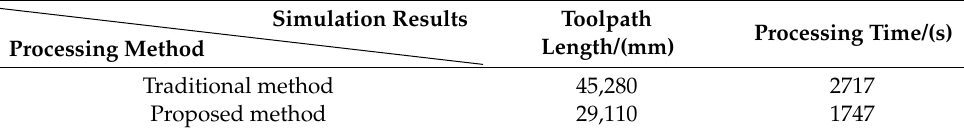
Table 2. Comparison of simulation results.